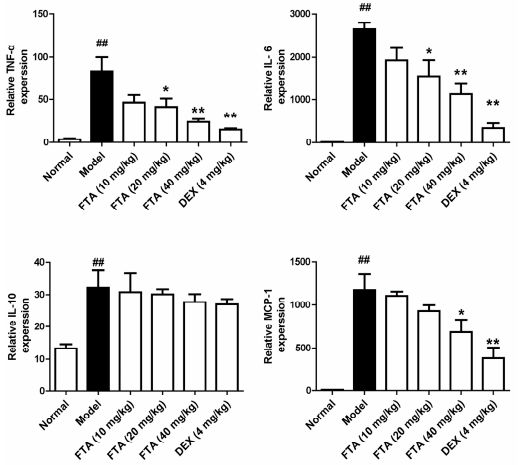
Figure 3. FTA treatment influences cytokines levels in peritoneal cavity. Levels of cytokines (TNF- α , IL-6, IL-10 and MCP-1) were determined by ELISA. Data were expressed as means ± SEM, n = 8. * p < 0.05, ** p < 0.01 vs. Model; ## p < 0.01 vs. Normal.